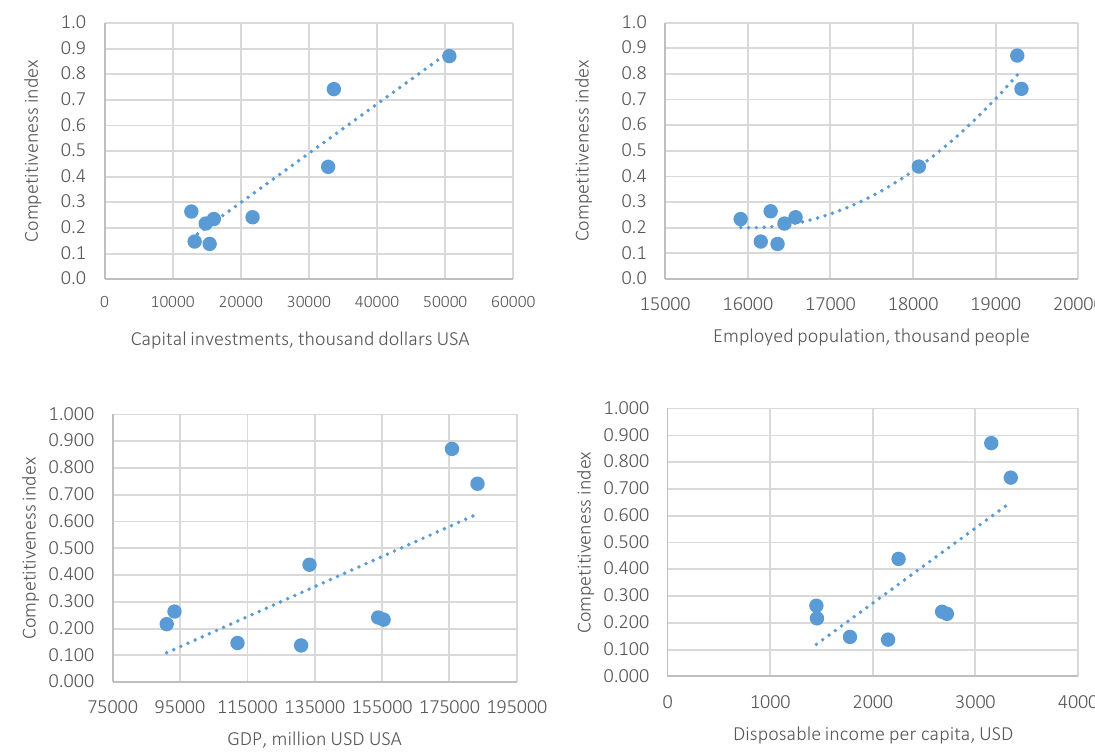
Figure 2. Correlation of the main economic crises indicators and the competitiveness index of insurance